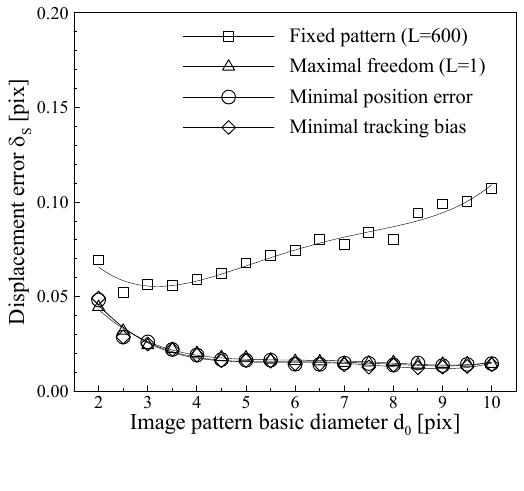
Figure 8. Displacement error distributions on image pattern size for different tracking freedom